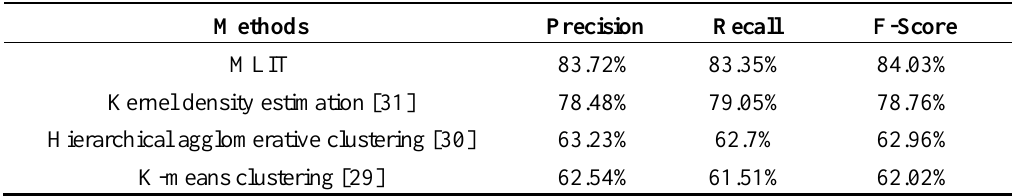
Table 3. Quantitative evaluation and comparison.